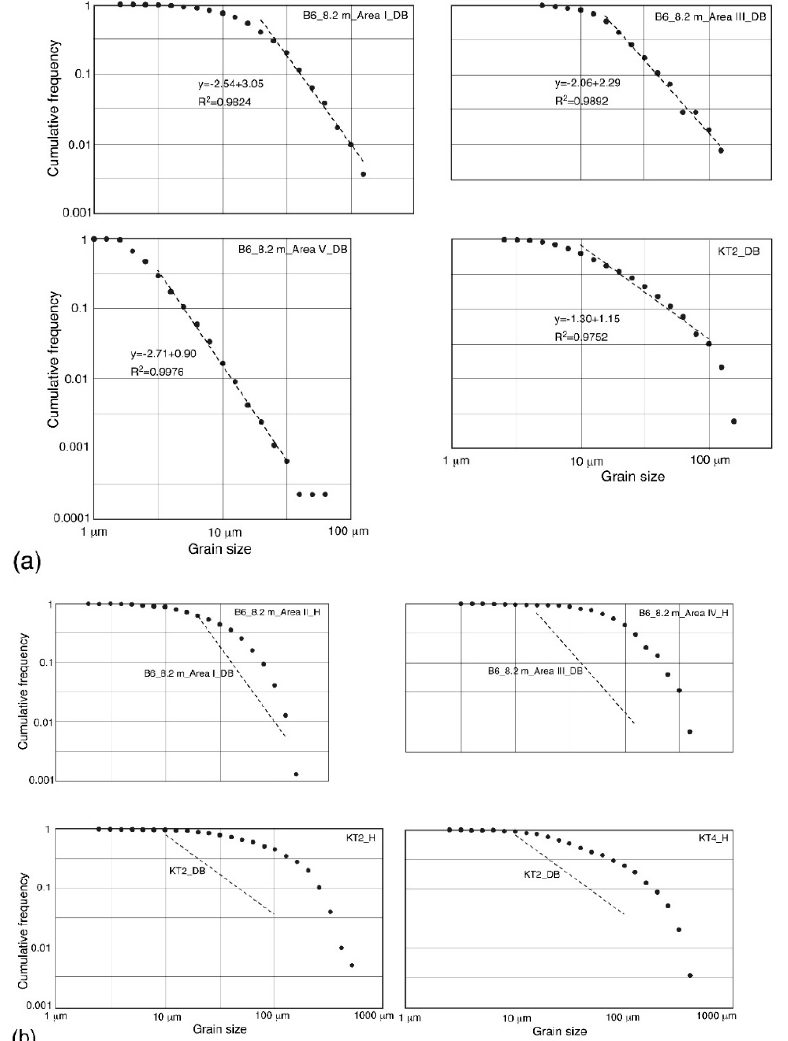
grains analyzed.